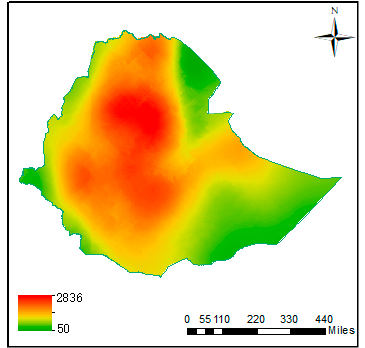
Figure 2. Topographic map of Ethiopia.